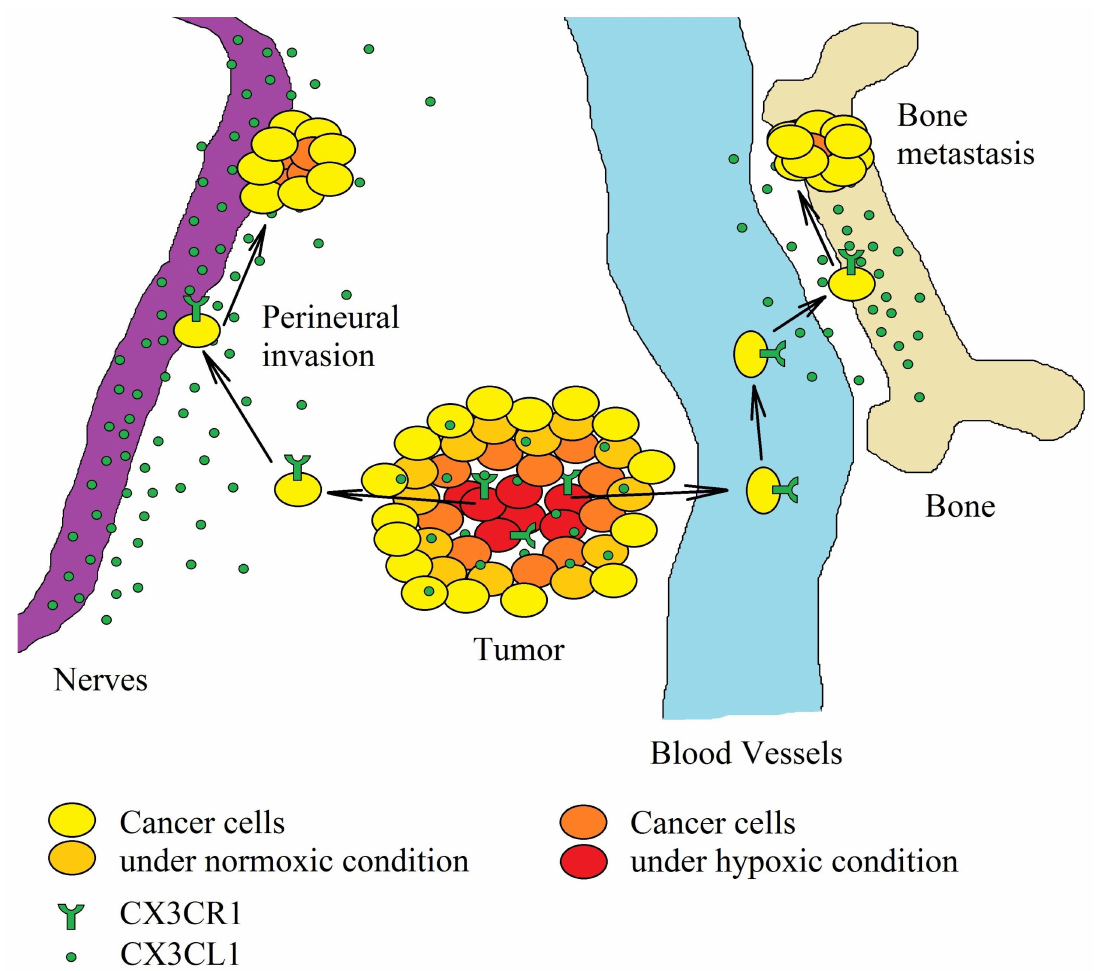
Figure 3. Significance of the CX3CL1-CX3CR1 axis in hypoxia-induced metastasis. Hypoxia induces an increase in CX3CR1 expression on cancer cells. The increased concentration of CX3CL1 in the tumor causes the migration of tumor cells. A neoplastic cell with CX3CR1 expression migrates to areas with a high CX3CL1 concentration within the same organ. Because neurons are one of the sources of this chemokine, perineural invasion may occur, often in pancreatic ductal adenocarcinoma. In the bloodstream, on the other hand, cancer cells with CX3CR1 expression migrate to the brain and bones—organs with a high expression of